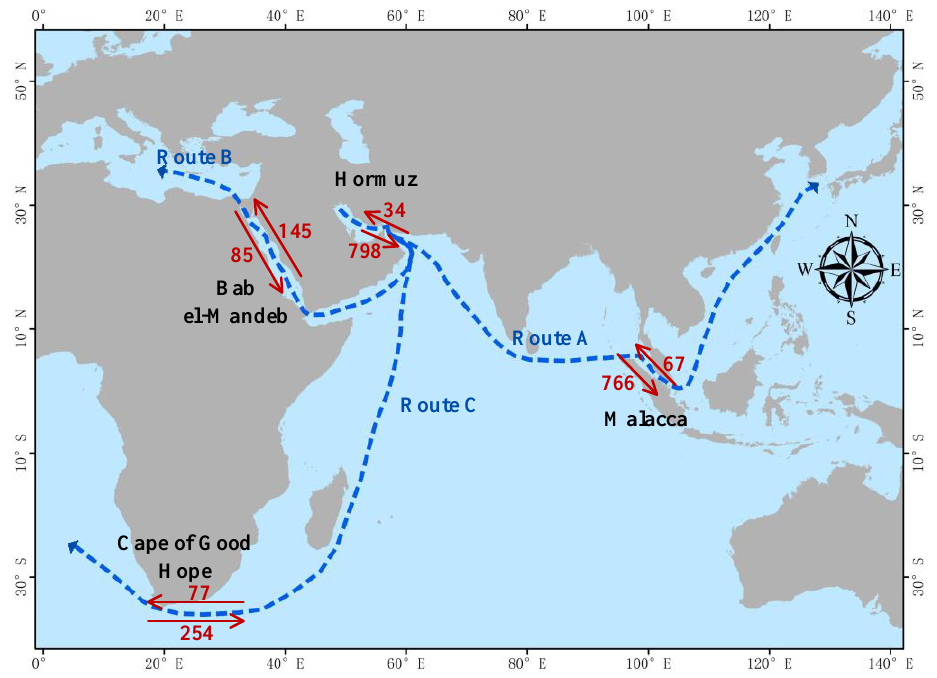
Figure 8. Two-way annual average oil flows of the four MOCs (units: 1 million tons).